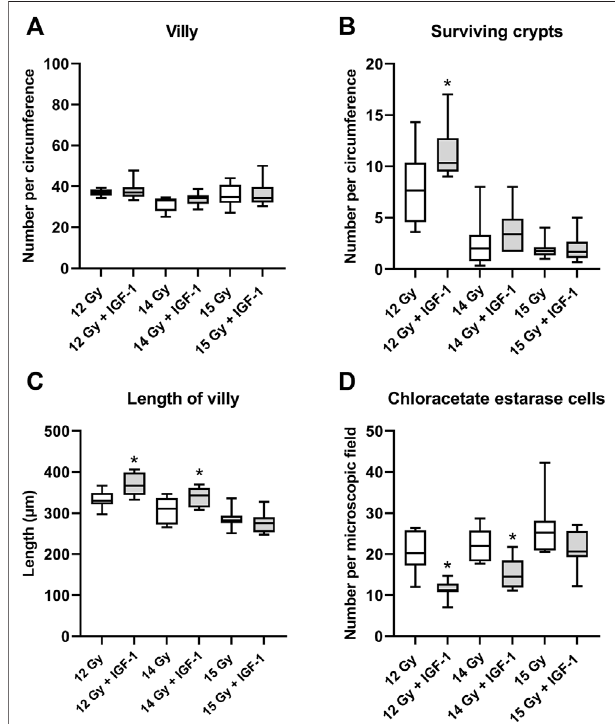
FIGURE 3 | Effect of IGF-1 at 1 mg/kg in the jejunum of mice irradiated by 12, 14, and 15 Gy with shielded head and neck. (A) number of villy. (B) number of surviving crypts. (C) length of villy. (D) chloroacetate esterase- positive cells in the subvillar mucose per centered microscopic fi eld at ×400 magni fi cation. Signi fi cantly different when compared with the solely irradiated group receiving no treatment: * p ≤